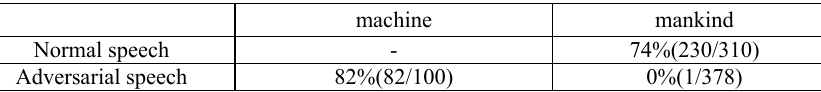
Table 2. Adversarial voice white box attack effect [3]